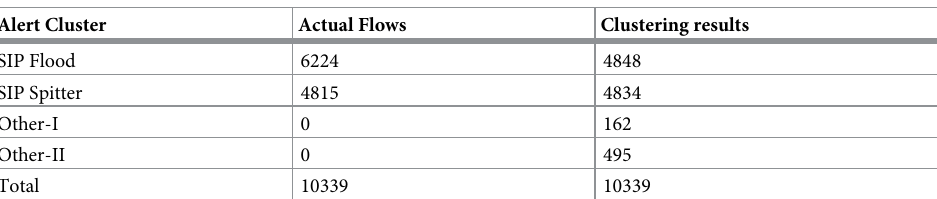
Table 12. SOM clustering results—SIP